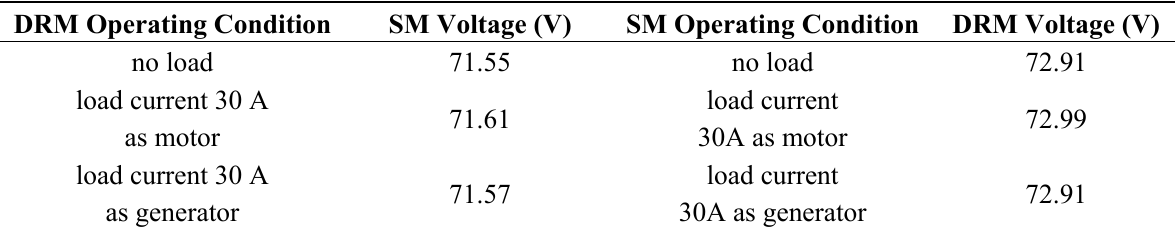
Table 3. Comparison of input